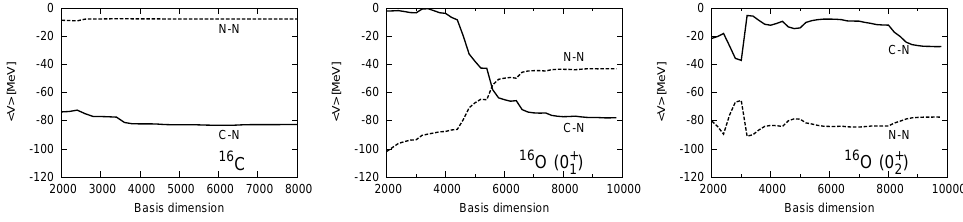
Figure 3. Expectation values of C (cid:0) N and N (cid:0) N potentials for the ground state of 16 C, the ground state of 16 O (0 + ), and the first excited state of 16 O (0 + ) from left to right, respectively, as functions of the number of 1 2